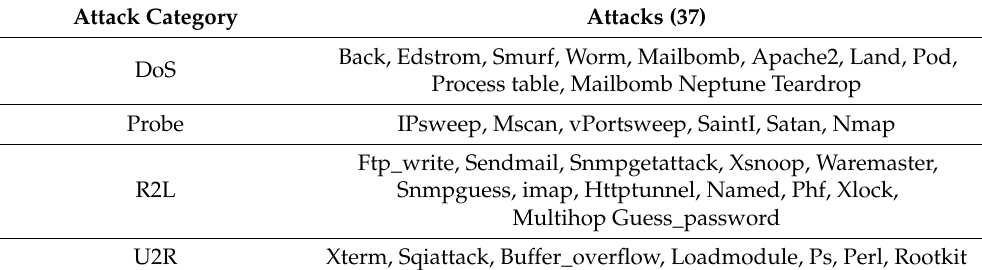
Table 4. KDDCUP99 Attack Types